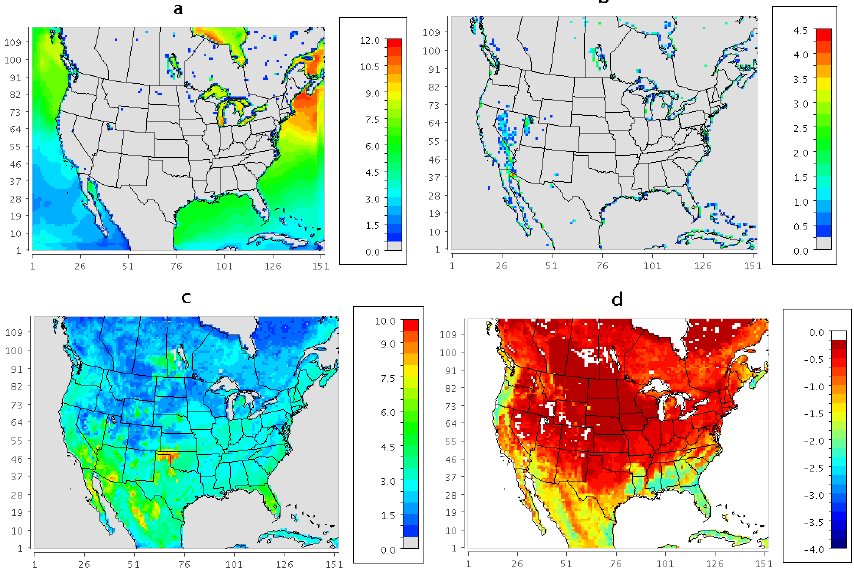
Figure 3. Monthly mean of the simulated Hg 0 flux (ngm − 2 h − 1 ) in the winter month: (a) flux from water bodies, (b) flux from bare lands, (c) flux from soil under the canopy and (d) flux from foliage.